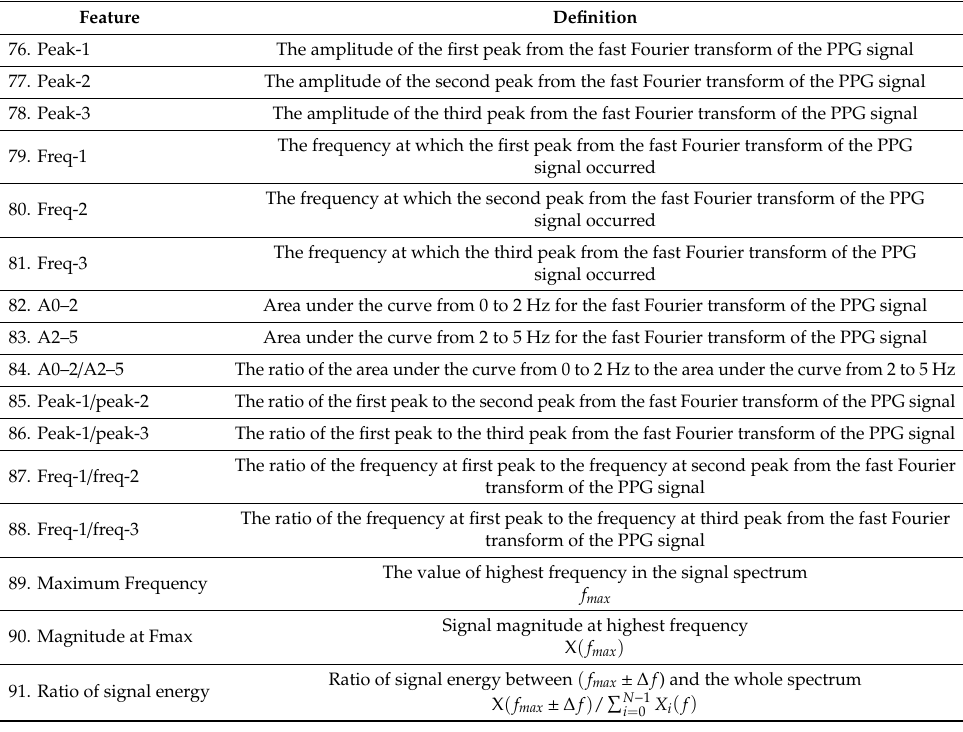
Table 6. Sixteen frequency-domain features.